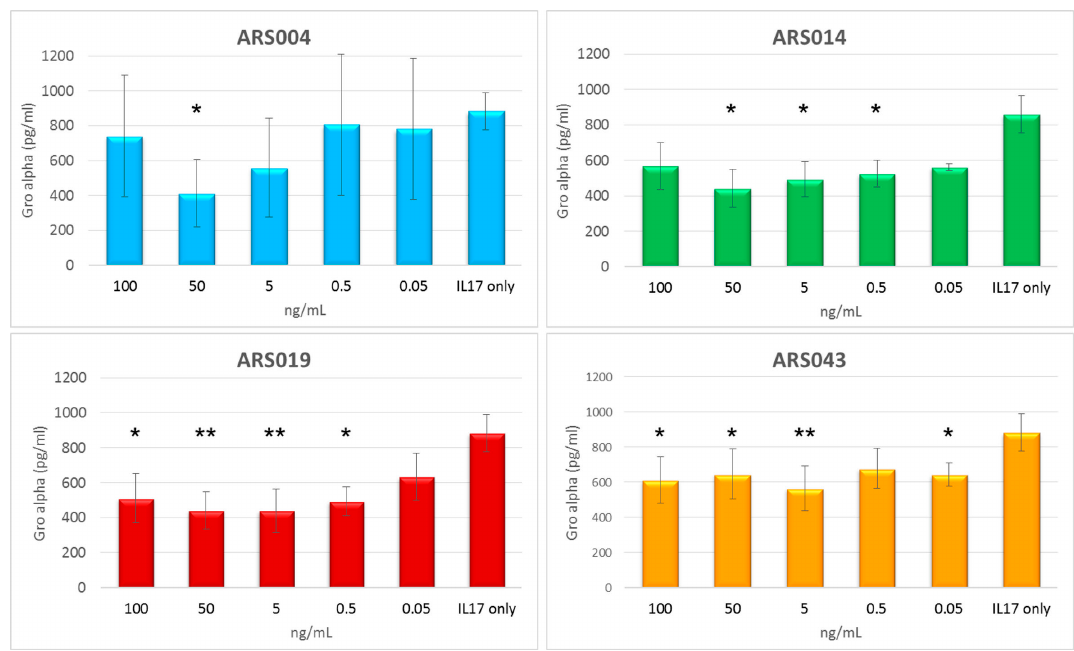
Figure 10. Test of immunomodulatory effect of the ARS ligands. The His 6 -ARS-TolA-AVI fusion proteins were added in different concentrations to medium containing IL-17A cytokine. As a control, medium with cytokine but without the ARS proteins was used (IL17 only). After 24 h, levels of Gro- α (CXCL1) secreted by CCD-1070Sk cells were measured by ELISA. Each bar represents the mean value ± SD of four (ARS019 and ARS043) or two (ARS004 and ARS014) independent experiments. Significant differences between mean values of the control (IL17 only) and the samples are shown (*, p < 0.05; **, p < 0.01; analysis of variance (ANOVA)).